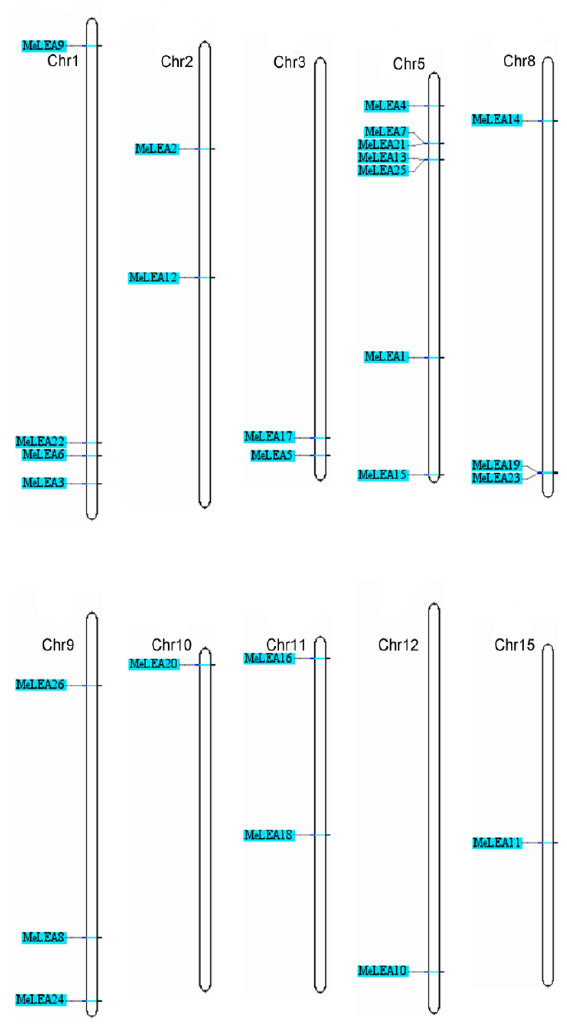
Figure 4. Distribution of the MeLEAs on chromosomes. The 26 MeLEAs were mapped to 10 chromosomes based on their chromosomal information of cassava.